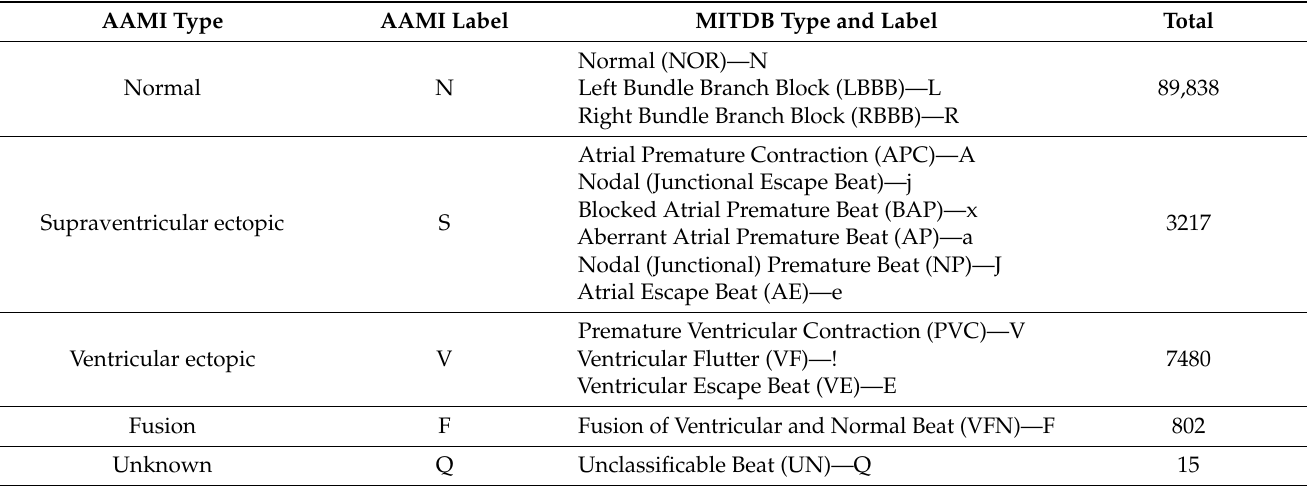
Table 1. MITDB labels of the heartbeats and corresponding standard AAMI